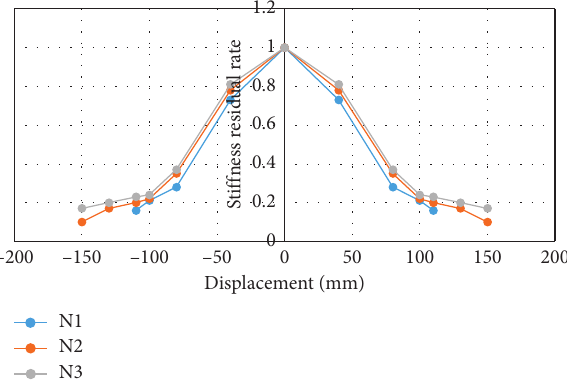
Figure 4: Node stiffness residual rate degradation